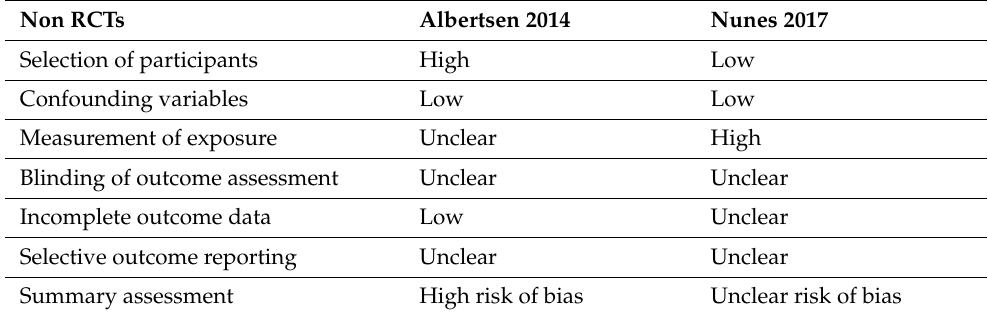
Table A3. Risk of Bias for non-RCT included